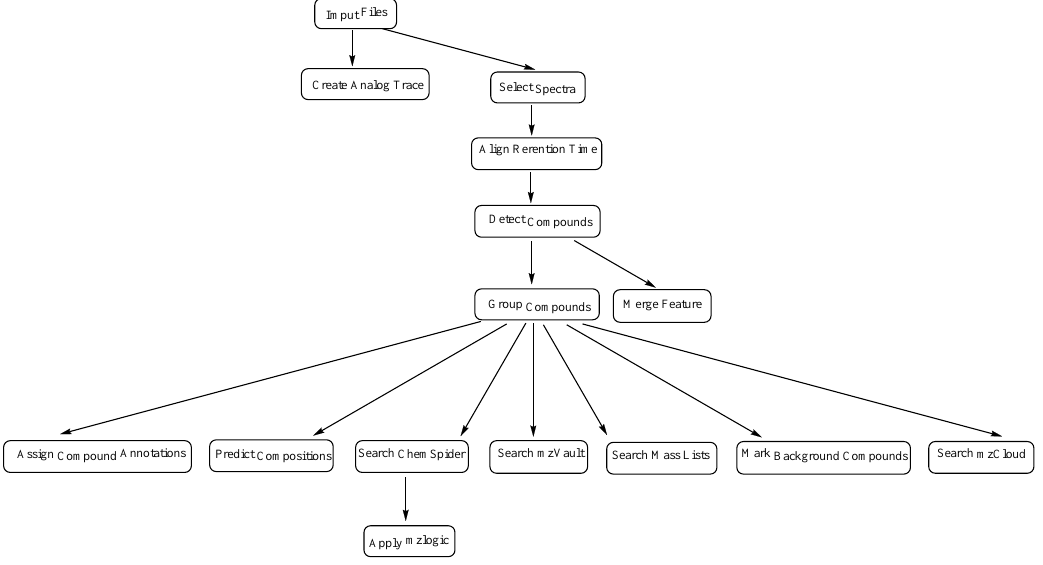
Figure 1. Method route of calculation.